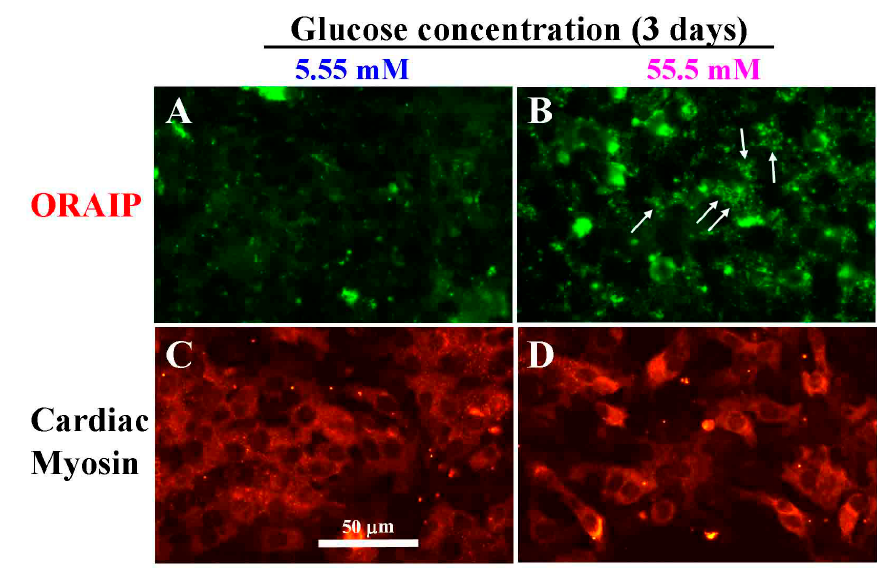
Figure 2. High glucose induces expression of ORAIP in cardiac myocytes in vitro. ( A , C ) Myocytes under normal concentration (5.55 mM) of glucose for three days; ( B , D ) Myocytes under high concentration (55.5 mM) of glucose for three days. ( A , B ) stained with anti-ORAIP mAb and labeled with fluorescein; ( C , D ) which correspond to A and B, respectively, show the staining pattern specific for cardiac myosin and labeled with TRITC. Bar, 50 μ m.